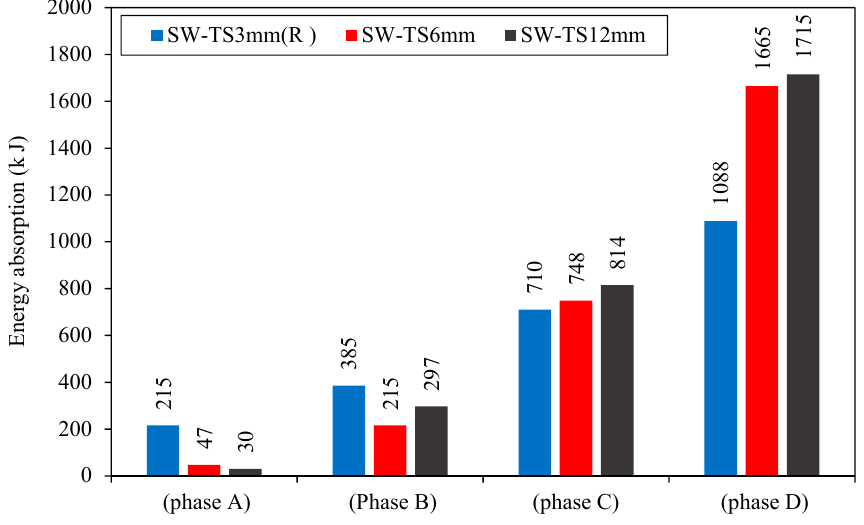
Figure 18. Energy absorption of group 2.